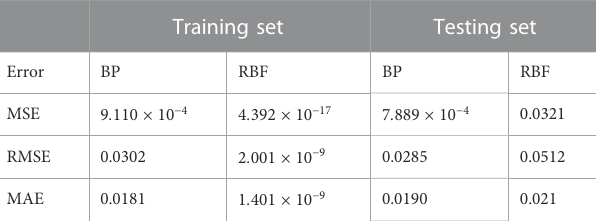
TABLE 5 Error between BP and RBF methods in training and testing data